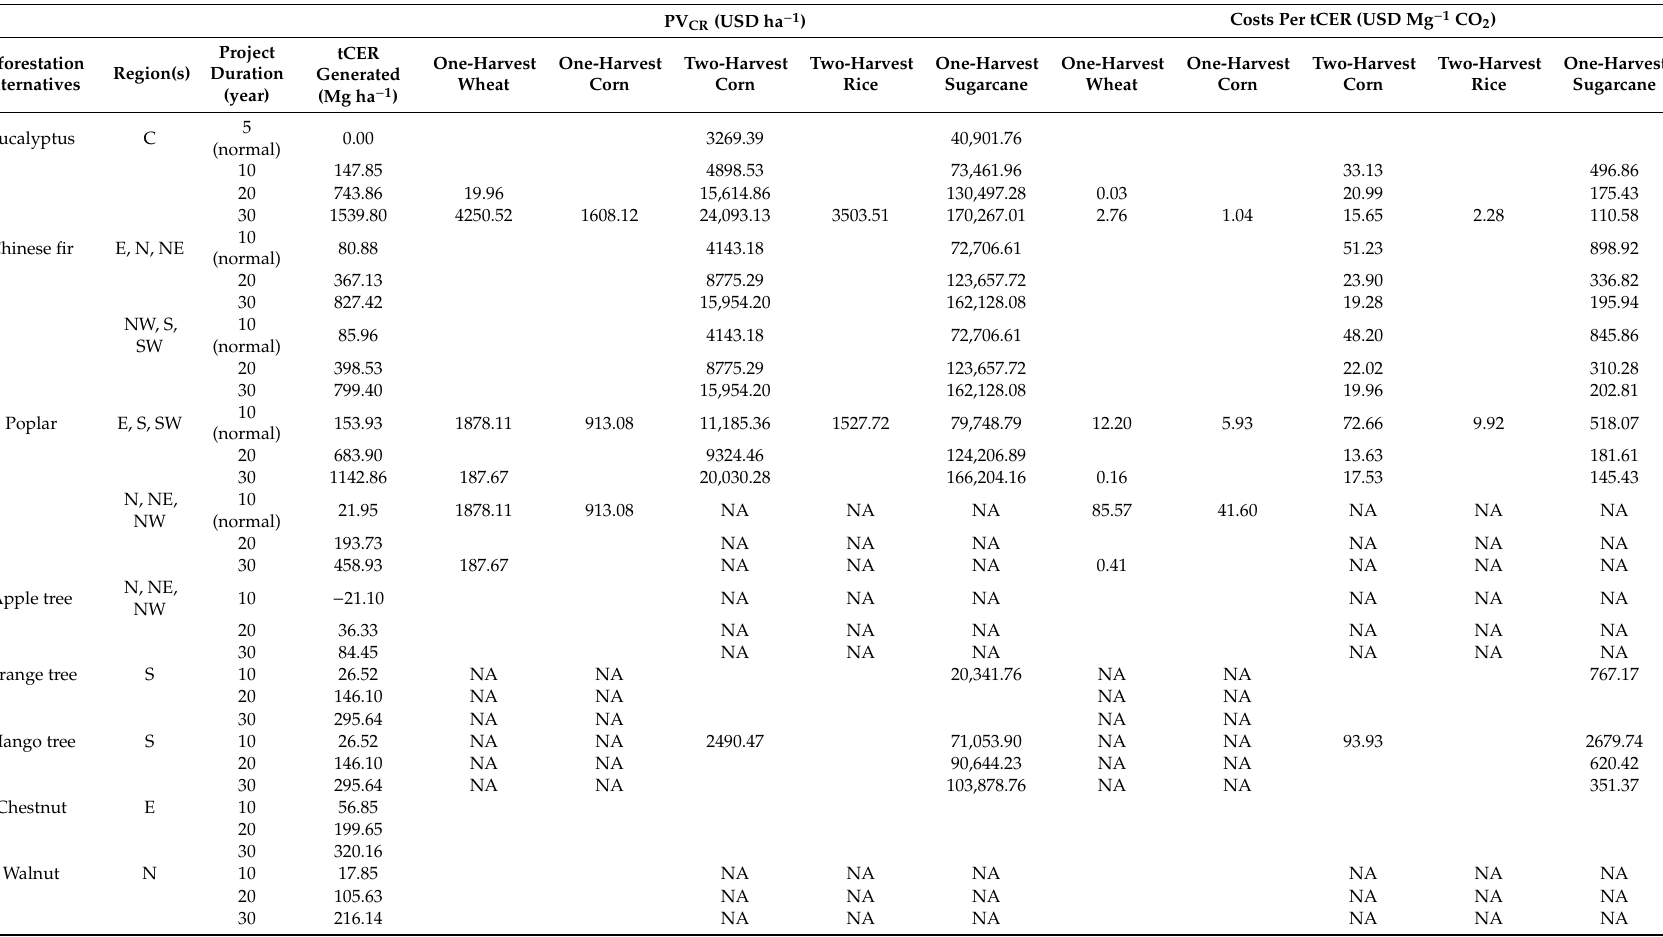
Table 6. Amount of temporary Certified Emission Reductions (tCER) (Mg ha − 1 ) generated, present value of carbon revenues (PV CR ) (USD ha − 1 ) required to make a ff orestation economically attractive, and minimum price per tCER (USD Mg − 1 CO 2 ) for di ff erent a ff orestation